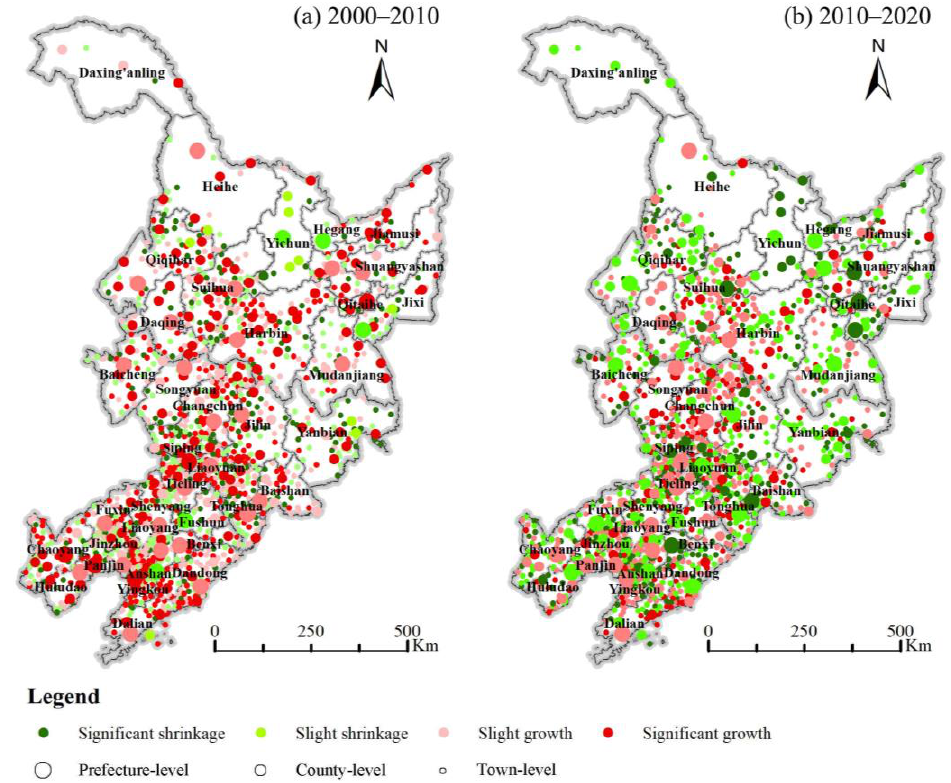
Figure 4. Spatial pattern of multi-level town shrinkage in Northeast China. Subfigure ( a ) shows the spatial pattern of multi-level town shrinkage in Northeast China during the period 2000–2010; Subfigure ( b ) shows the spatial pattern of multi-level town shrinkage in Northeast China during the period 2010 – 2020.